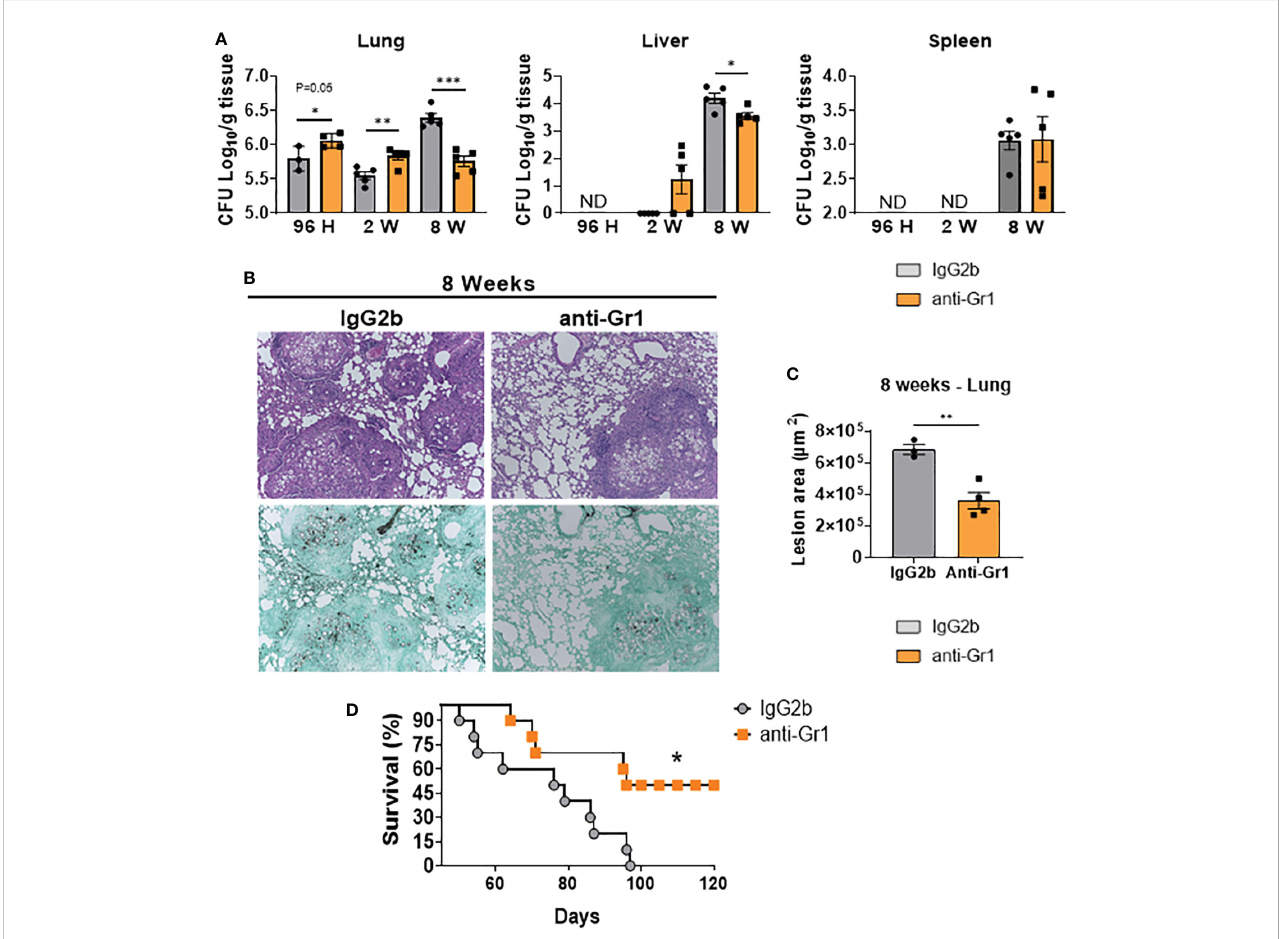
FIGURE 10 Depletion of MDSCs reduces fungal loads and tissue injury at the chronic phase of the disease and reduces mortality rates of P. brasiliensis -infected mice. C57BL/6 WT mice were infected i.t. with 1×10 6 yeasts cells of P. brasiliensis . After 24 hours, 1 week, and 7 weeks of infection a group of mice received intraperitoneal injections of anti-Gr1 (clone RB6-8C5) or rat IgG2b isotype (200 µg/dose). Colony-forming unit (CFU) counts from lungs, liver, and spleen were determined 96 hours, 2 weeks, and 8 weeks after P. brasiliensis infection (A) . Photomicrographs of lung lesions of control and anti-Gr1- depleted mice at week 8 of infection. Lesions were stained with hematoxylin-eosin (top panels) and Grocott (bottom panels) (B) . Total area of lesions in the lungs at 8 weeks of infection. (C) . Survival curves of MDSCs-depleted and control infected mice were determined for a period of 120 days (D) . The bars represent means ± standard errors of the mean (SEM) of log10 CFU counts obtained from groups of 3 – 4 mice. For comparisons between two groups, the mean ± SEM was obtained and analyzed by the unpaired Student ’ s t -test. Differences were considered signi fi cant when: * p <0.05; ** p <0.01 and *** p